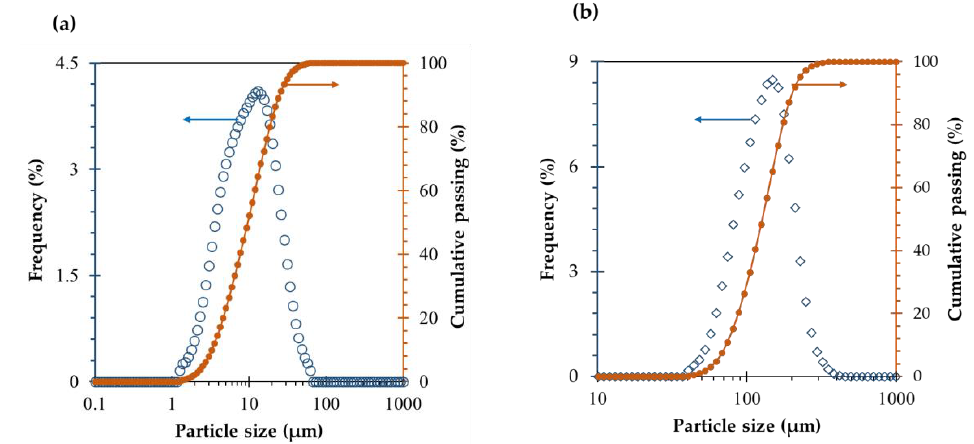
Figure 3. The particle size distribution of ( a ) zinc plant leach residues and ( b ) zero-valent aluminum.